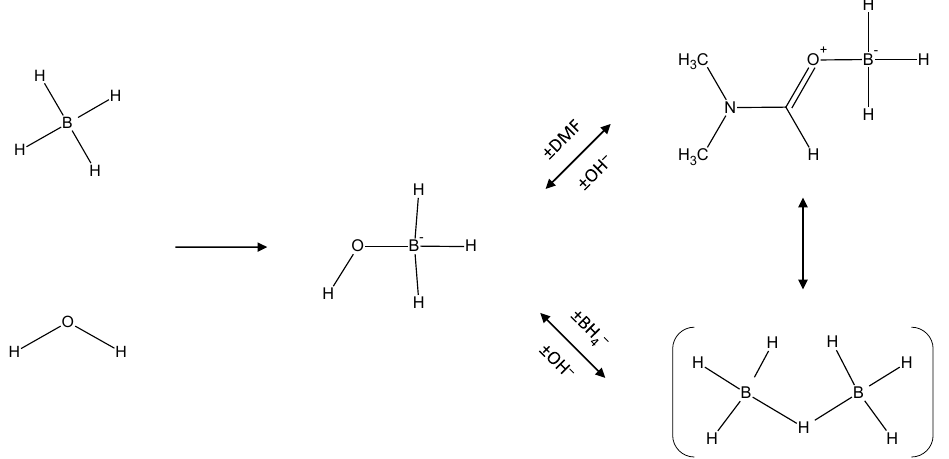
Figure 6. Mechanistic sequence illustrating the formation of the identified BH 3 -based intermediates BH 3 OH − , DMF·BH 3 , and B 2 H 7− .